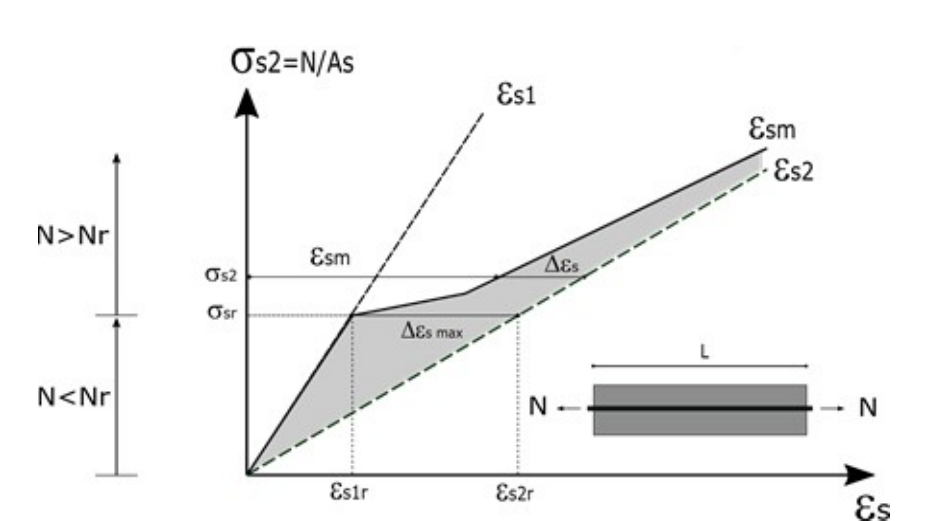
Figure 2. Relative strain of the reinforcement in the tension stiffening